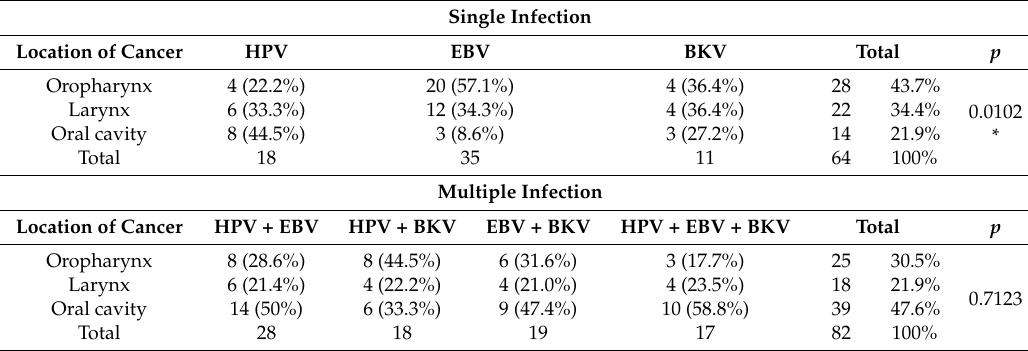
Table 3. Prevalence of single and multiple infection according to location of cancer.